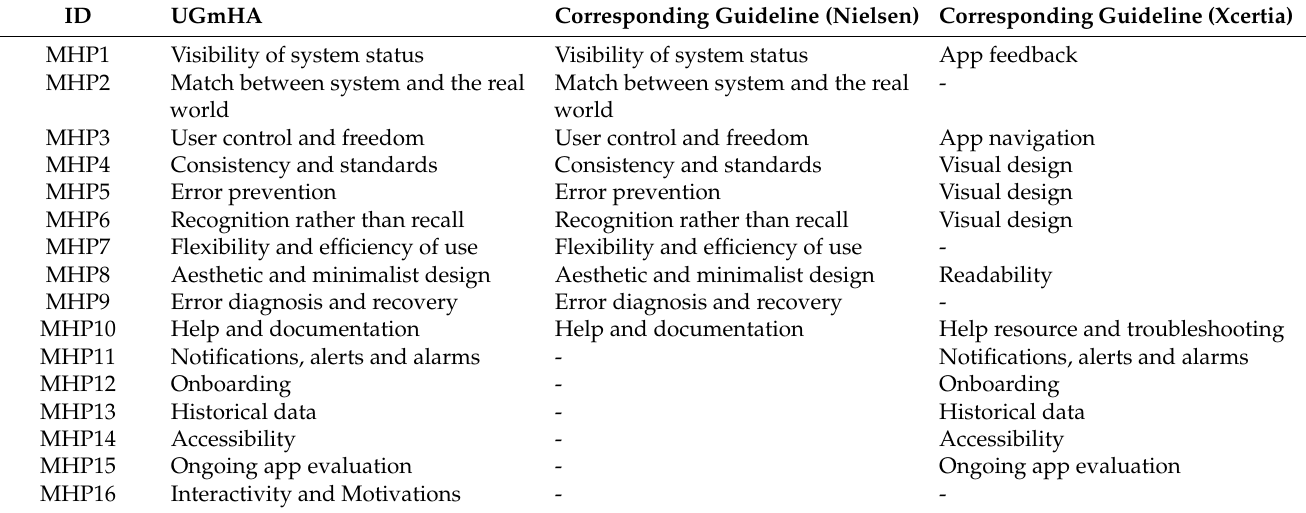
Table 13. Relation of the UGmHA guidelines with Nielsen and